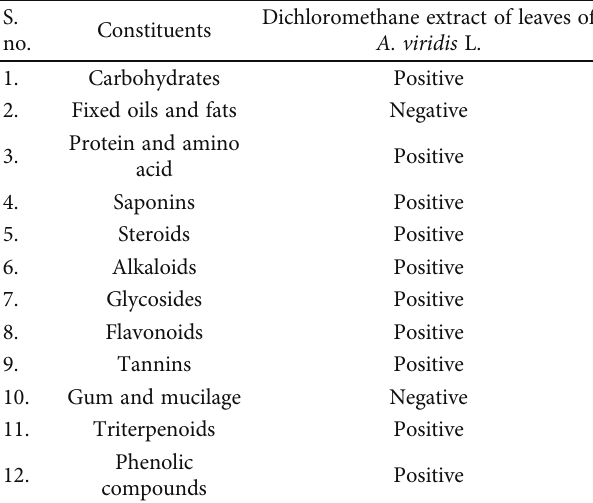
Table 2: Outcomes of phytochemical